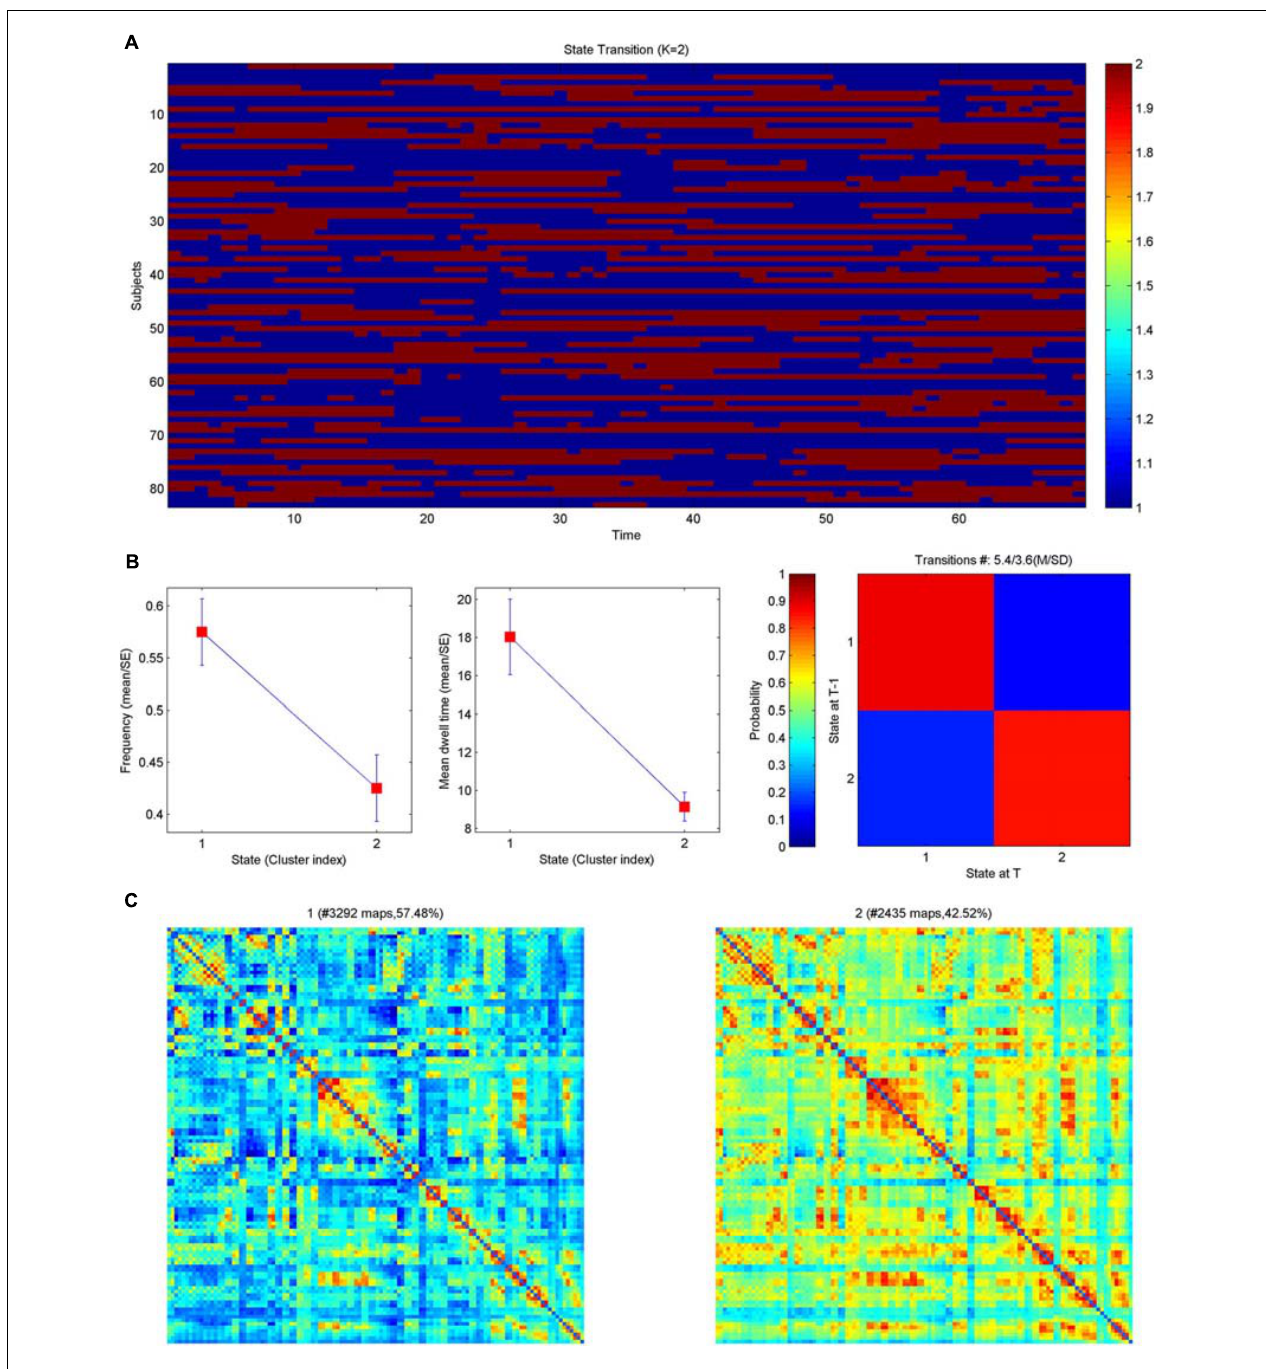
FIGURE 4 | Clustering analysis of dynamic brain functional networks. (A) Brain network distribution of each subject over time. Blue represents state 1; red represents state 2; the horizontal axis is time, which can also be interpreted as the number of networks (69) and the vertical axis is the subject. (B) Left: average frequency of the two network states (corresponding to metric F below), middle: average dwell time of the two network states (corresponding to the metric MDT below), right: state transfer moment; blue represents state 1 and red represents state 2. (C) The matrix plot distribution of the two networks is shown on the left for state 1 with 57.48% and on the right for state 2 with 42.42%, both of which together are